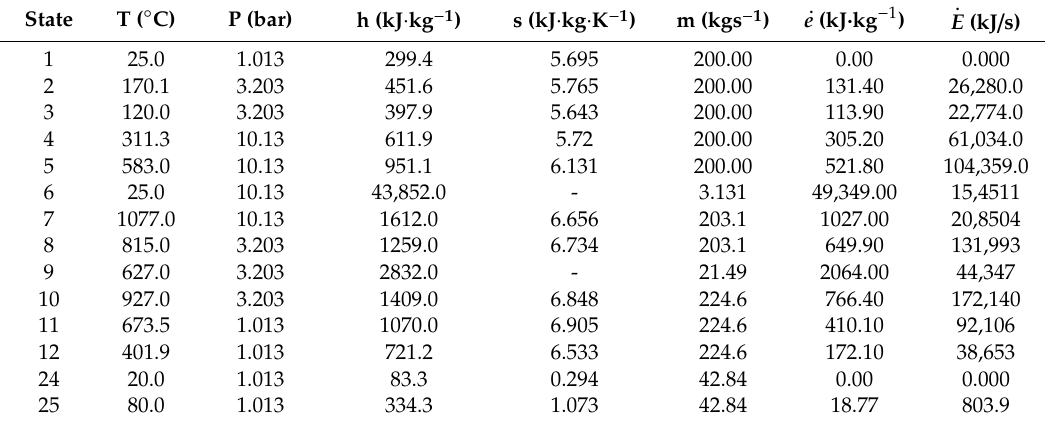
Table A1. Thermodynamic state point properties for the gas turbine in the IMP.